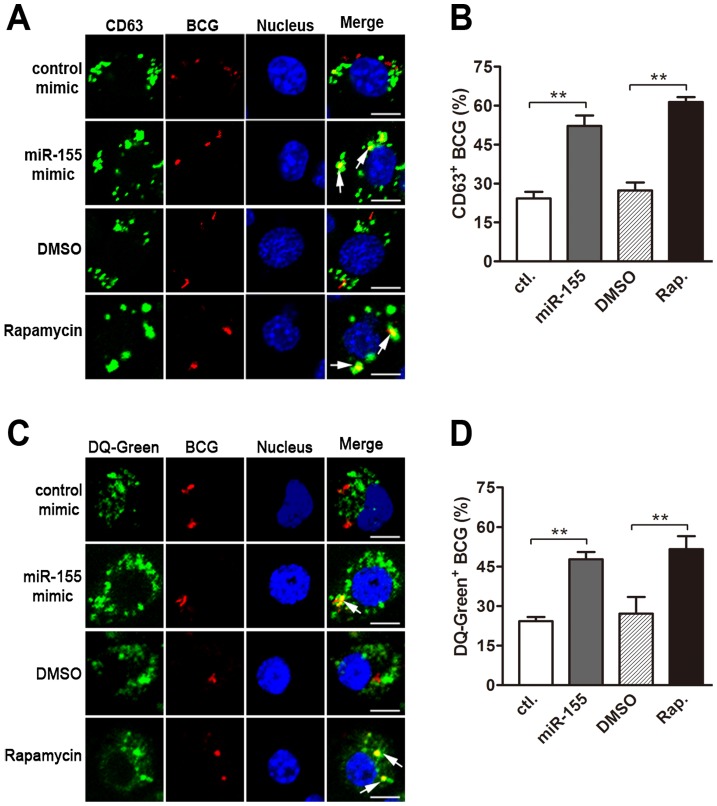
miR-155 promotes mycobacterial phagosome maturation.RAW 264.7 cells were transiently transfected with control or miR-155 mimic for 24 h and then infected with Texas Red-labeled BCG for 1 h. Lysosomes were immunolabeled with CD63 antibody followed by Alexa Fluor 488-conjugated goat anti-rabbit IgG antibody (A), or labeled with a fluorogenic substrate for proteases, DQ-Green (C). The colocalization of BCG with lysosome was detected by confocal microscopy. The percentage of co-localization of BCG with CD63-positive (B) or DQ-Green labeled (D) lysosomes was quantified, respectively. Cells treated with rapamycin were used as a positive control. Arrows indicate the co-localization of BCG with lysosomes; scale bar = 5 µm. Quantification of data are shown as the mean ± SEM of three independent experiments (n = 100 phagosomes). **, p<0.01.